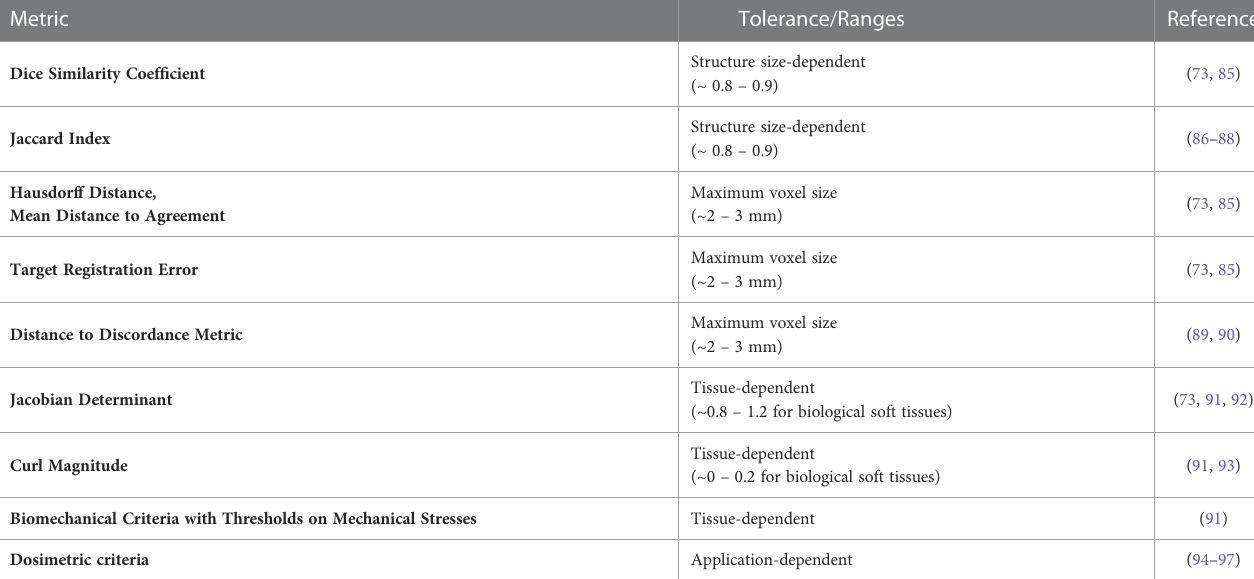
TABLE 1 Summary of quality assurance metrics for deformable image registration (DIR) and recommended